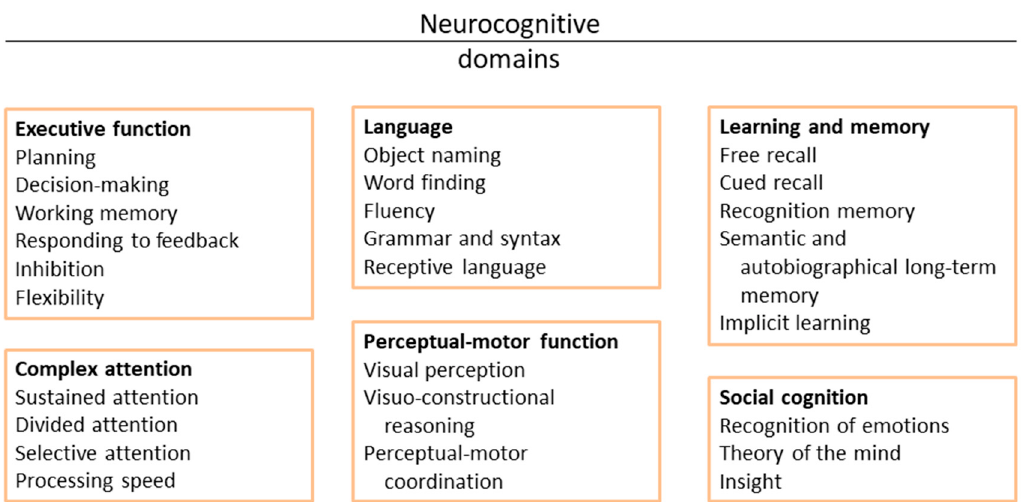
Figure 1. Cognitive domains and subdomains. The figure represents the classification of the cognitive domains and subdomains proposed by the DSM-5.